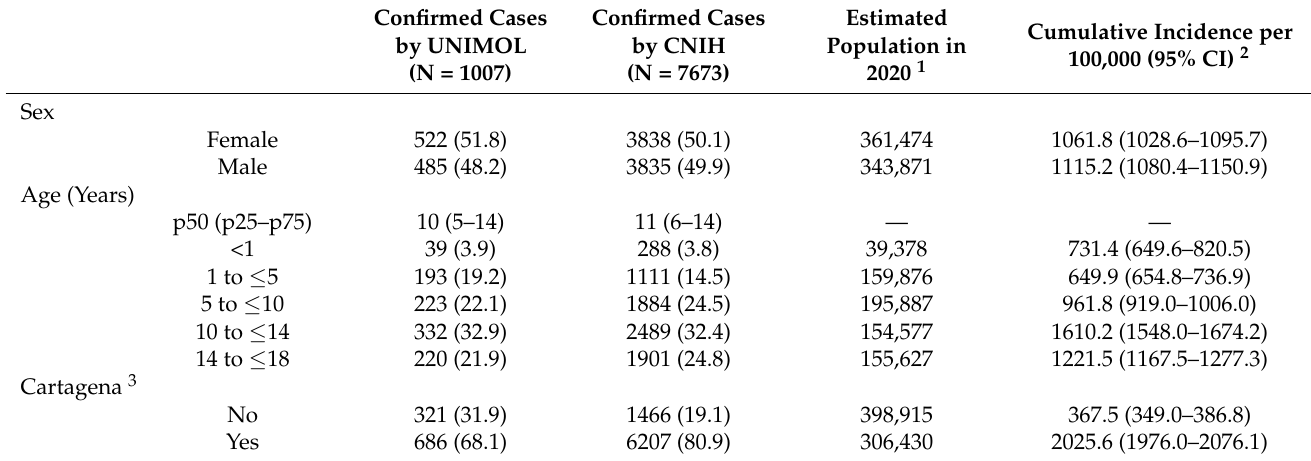
Table 1. Characteristics of children with COVID-19 in Bol í var department and its capital